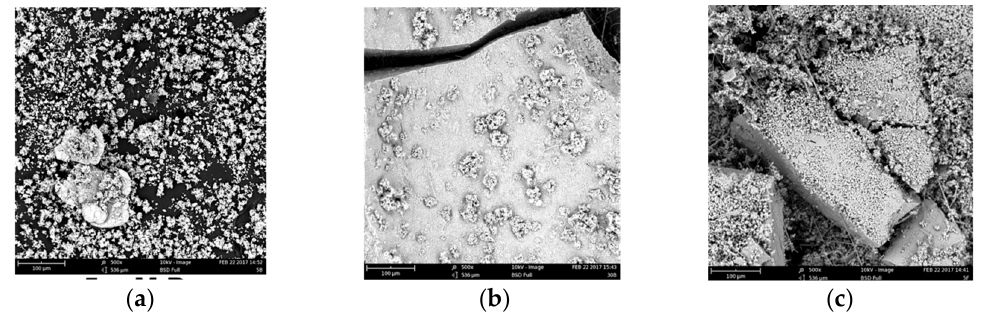
Figure 6. SEM images of precipitates from unseeded experiments ( a ) 5 mM; ( b ) 30 mM [Pi] and precipitate-seeded experiments ( c ) 7 mM [Pi].